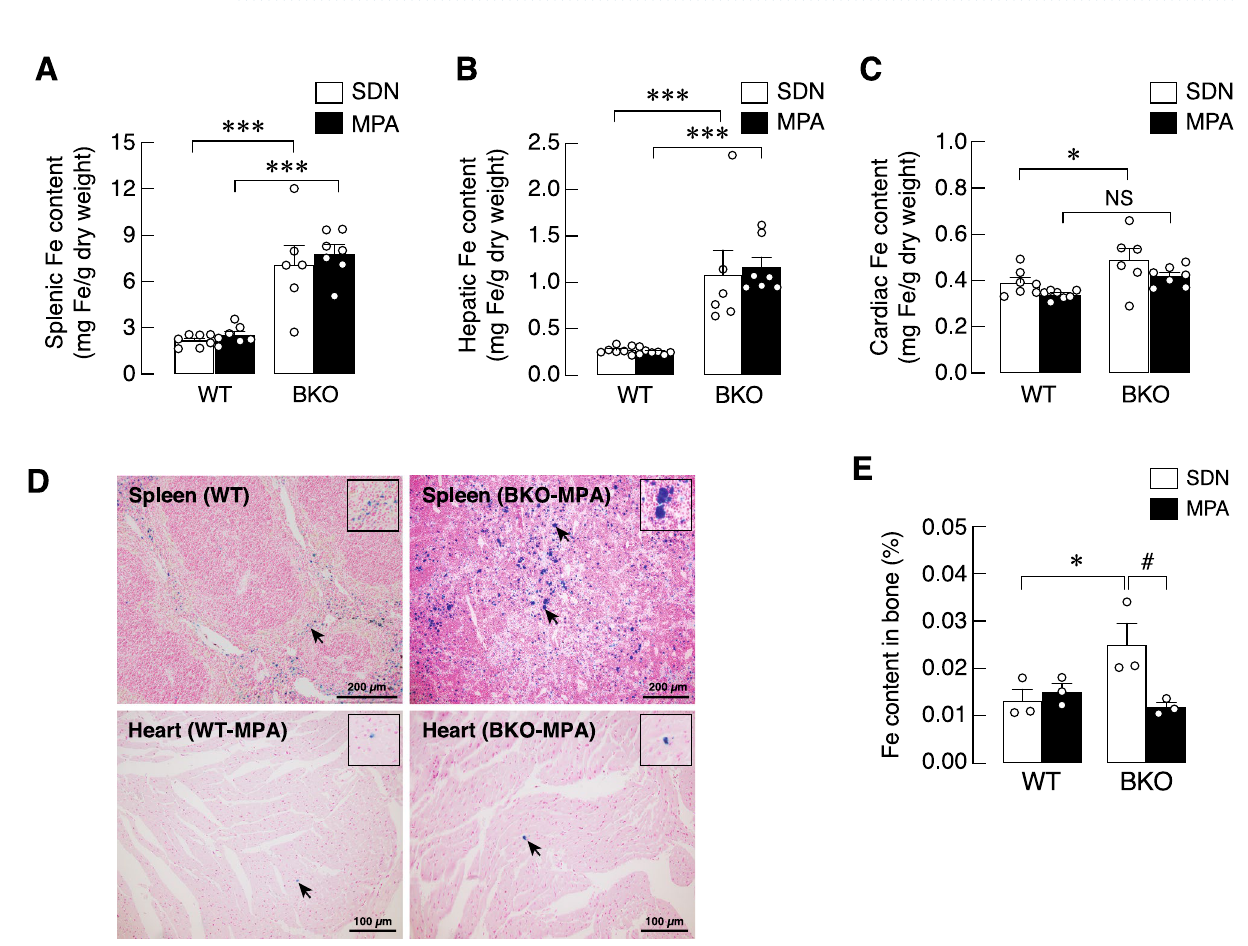
Figure 2. Tissue iron content in β-globin knockout (BKO) and wild-type (WT) mice after mild-intensity physical activity (MPA) training or sedentary (SDN) period. ( A – C ) Tissue iron (Fe) content in spleen, liver, and heart were measured by FAAS and normalized by tissue dry weight (n = 6–7). NS, not significant. ( D ) Representative photomicrographs of Prussian blue staining in the spleen and heart tissue obtained from WT and BKO mice (n = 6–7). Iron accumulation stained blue, nuclei stained red. Scale bars are presented in the lower right of each picture. ( E ) Iron content in bone was analyzed by FAAS (n = 3). Values are means ± SE. * P < 0.05, *** P < 0.001 vs. corresponding age-matched WT group. # P < 0.05 vs. SDN